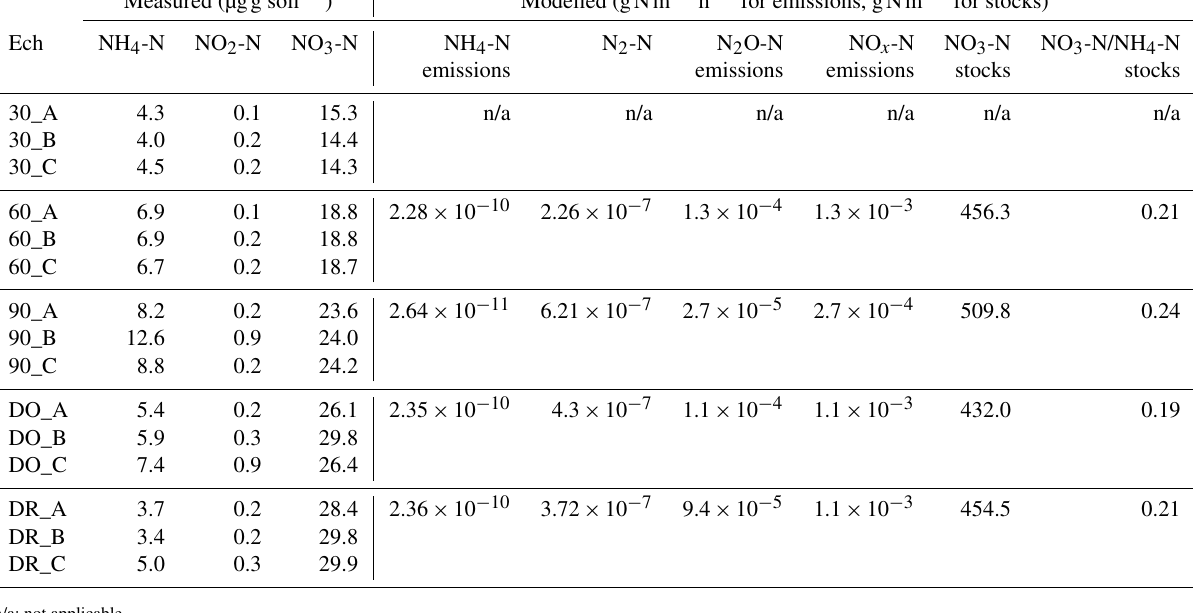
Table 1. N species measured in the soils at the end of initial incubation period further used to initialise the DNDC model, mean modelled NO 3 -N stocks and mean emissions of NH 4 -N, N 2 -N, N 2 O-N and NO x -N modelled without Cu. Notation is as follows: 90 is 90% WHC, 60 is 60% WHC, DO is Dry-Only and DR is Dry-Rewet treatment during initial incubation. A, B and C are replicates.